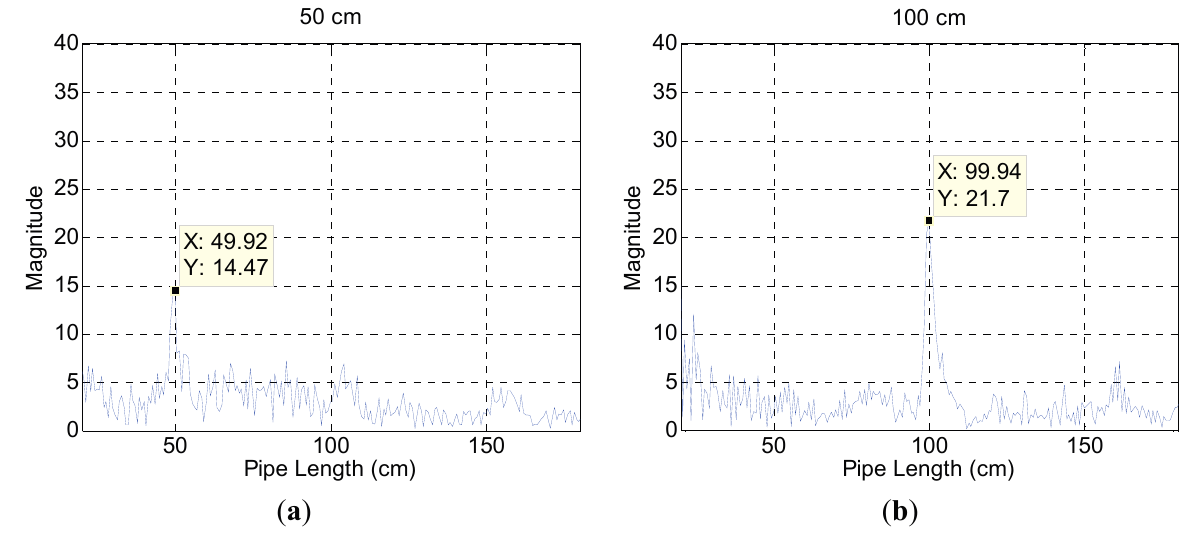
Figure 4. Range-limited output plot ( a ) for a 50 cm pipe; and ( b ) for a 100 cm